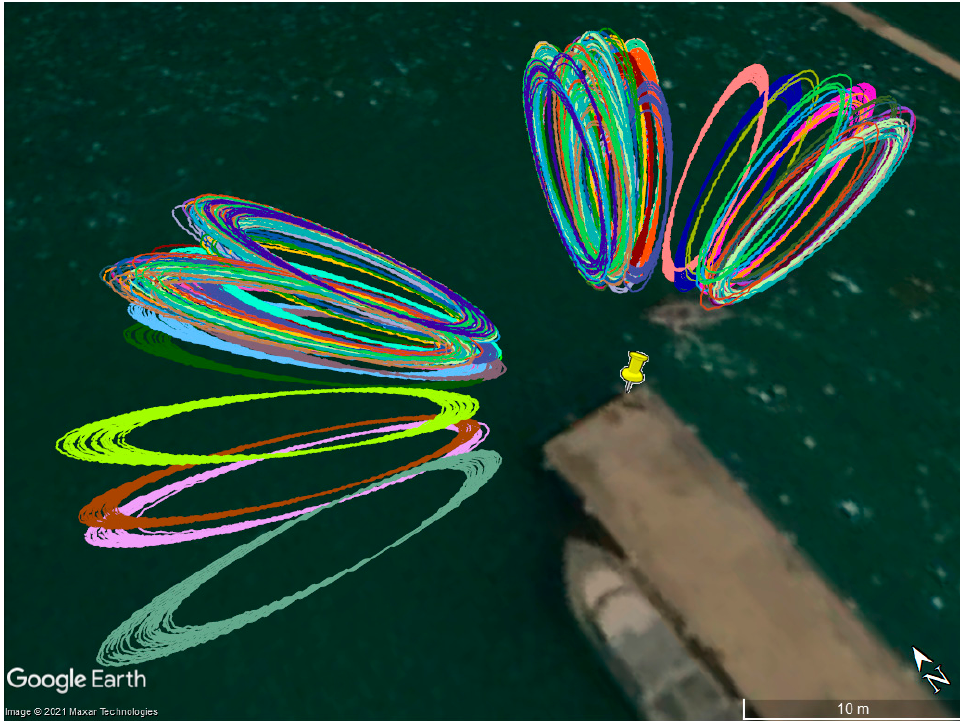
Figure 2. Occurrences of FFZs in January 2021 at the POPR. Each color depicts a GNSS satellite, and the location of the Port-au-Prince tide gauge station is shown as a yellow pin.